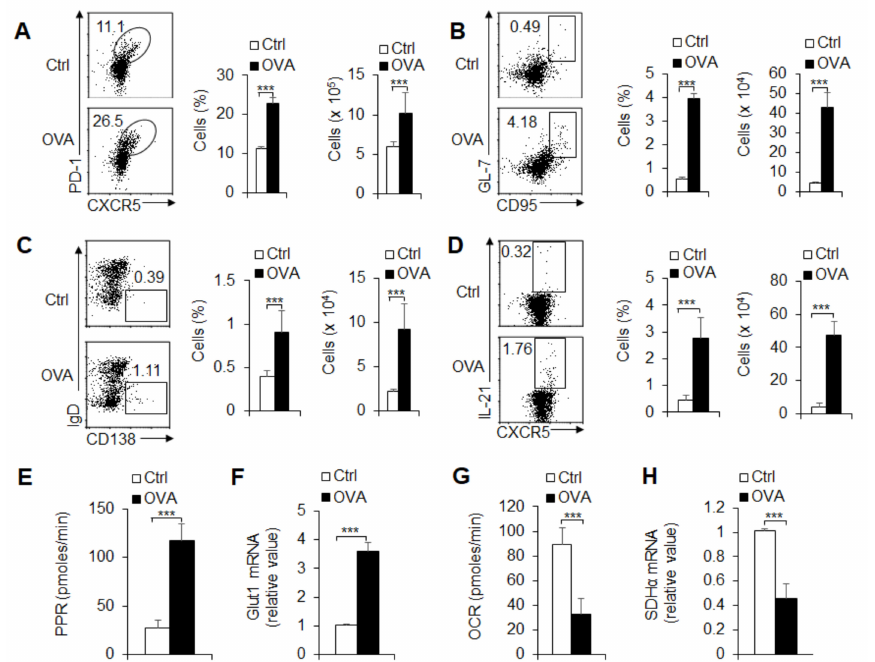
Figure 2. T FH cell di ff erentiation is associated with glycolysis and OXPHOS with OVA immunization. WT mice underwent intraperitoneal immunization with OVA plus LPS in alum at 8 days, and spleens were isolated for analysis. ( A ) Flow cytometry of T FH cells in spleens. The right panel shows the frequency and the number of T FH cells. ( B , C ) Flow cytometry of GC B cells and plasma cells in spleens; the statistical results are also shown. ( D ) The secretion of IL-21 in CXCR5 + PD1 + CD4 + T FH cells in spleens. The right panel shows the frequency and the number of IL-21 + T FH cells. ( E ) The proton production rate (PPR) was examined as a readout for glycolysis of CXCR5 + PD1 + CD4 + T FH cells sorted from splenocytes. ( F ) Glut1 mRNA expression was analyzed by real-time PCR in CXCR5 + PD1 + CD4 + T FH cells sorted from splenocytes. ( G ) The oxygen consumption rate (OCR) was examined as a readout for OXPHOS of CXCR5 + PD1 + CD4 + T FH cells sorted from splenocytes. ( H ) Sdh α mRNA expression was analyzed by real-time PCR in CXCR5 + PD1 + CD4 + T FH cells sorted from the splenocytes. Data are representative of four individual experiments (n = 3–7 mice per group). *** p < 0.001, compared with the indicated